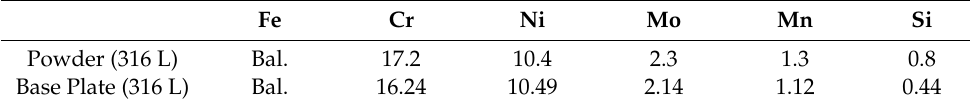
Table 2. Powder and base plate Steel 316 L chemical composition